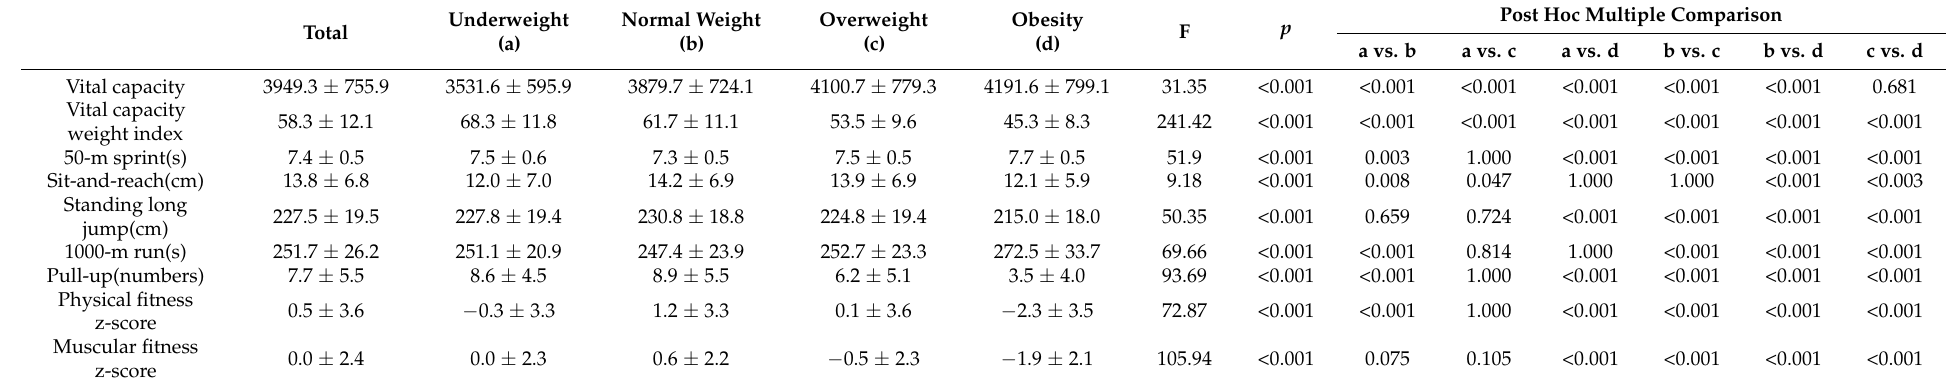
Table 2. Difference of physical fitness stratified by BMI category in male college students.